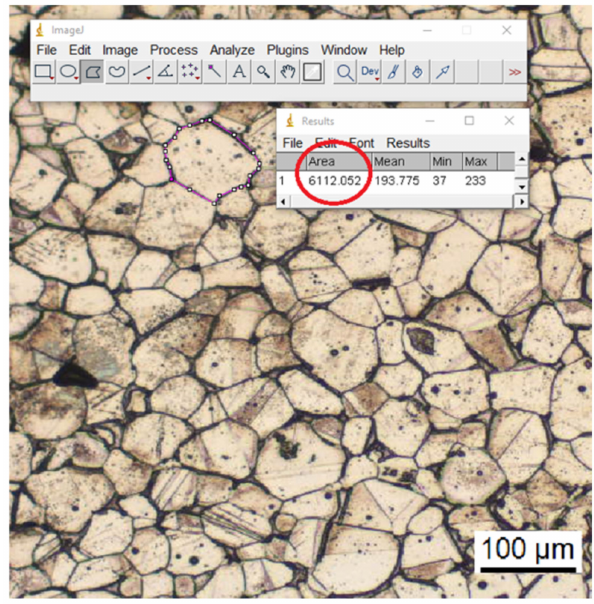
Figure 2. Procedure employed with the software Image J to evaluate grain